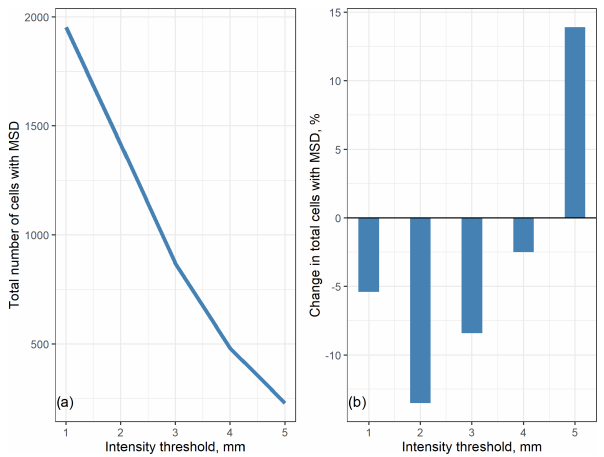
Figure 8. (a) Total number of MSD pixels (only those classified as MSD in both periods) and (b) change in the number of pixels classified as experiencing an MSD between 1981–2000 and